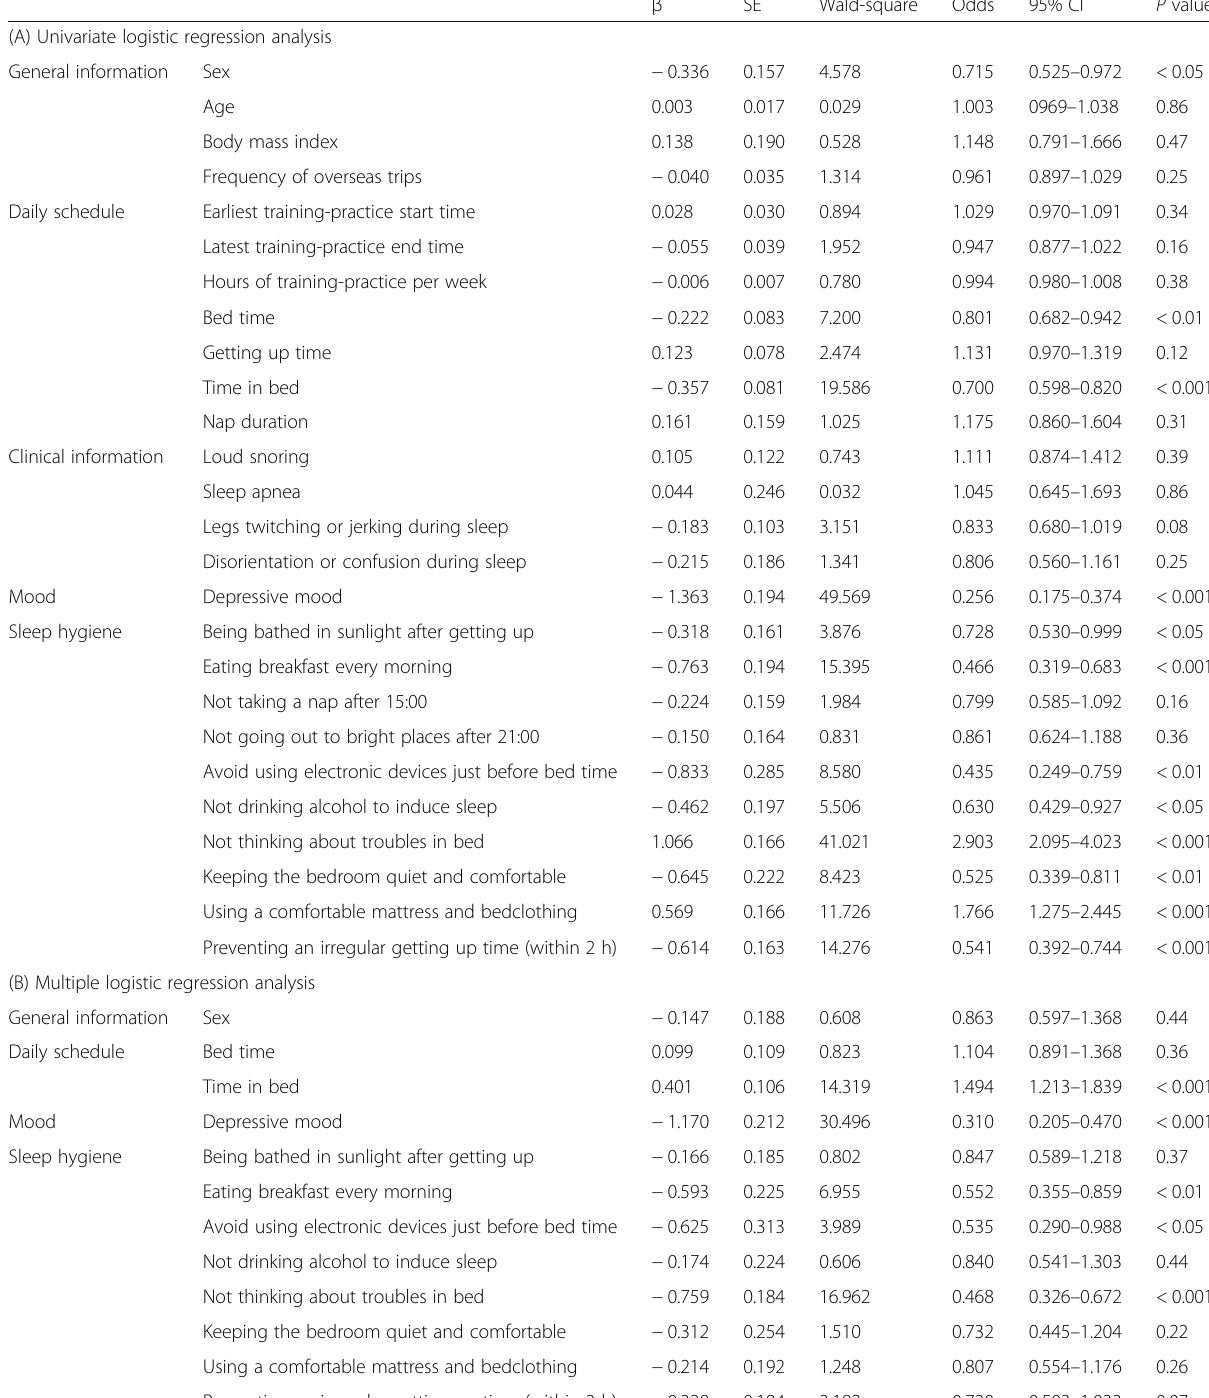
Table 5 The associations amongst sex, age, body mass index, experience of overseas trips, training-practice schedule, depressive mood and sleep habits, and poor sleep quality (PSQI global score > 5.5) β SE Wald-square Odds 95% CI P